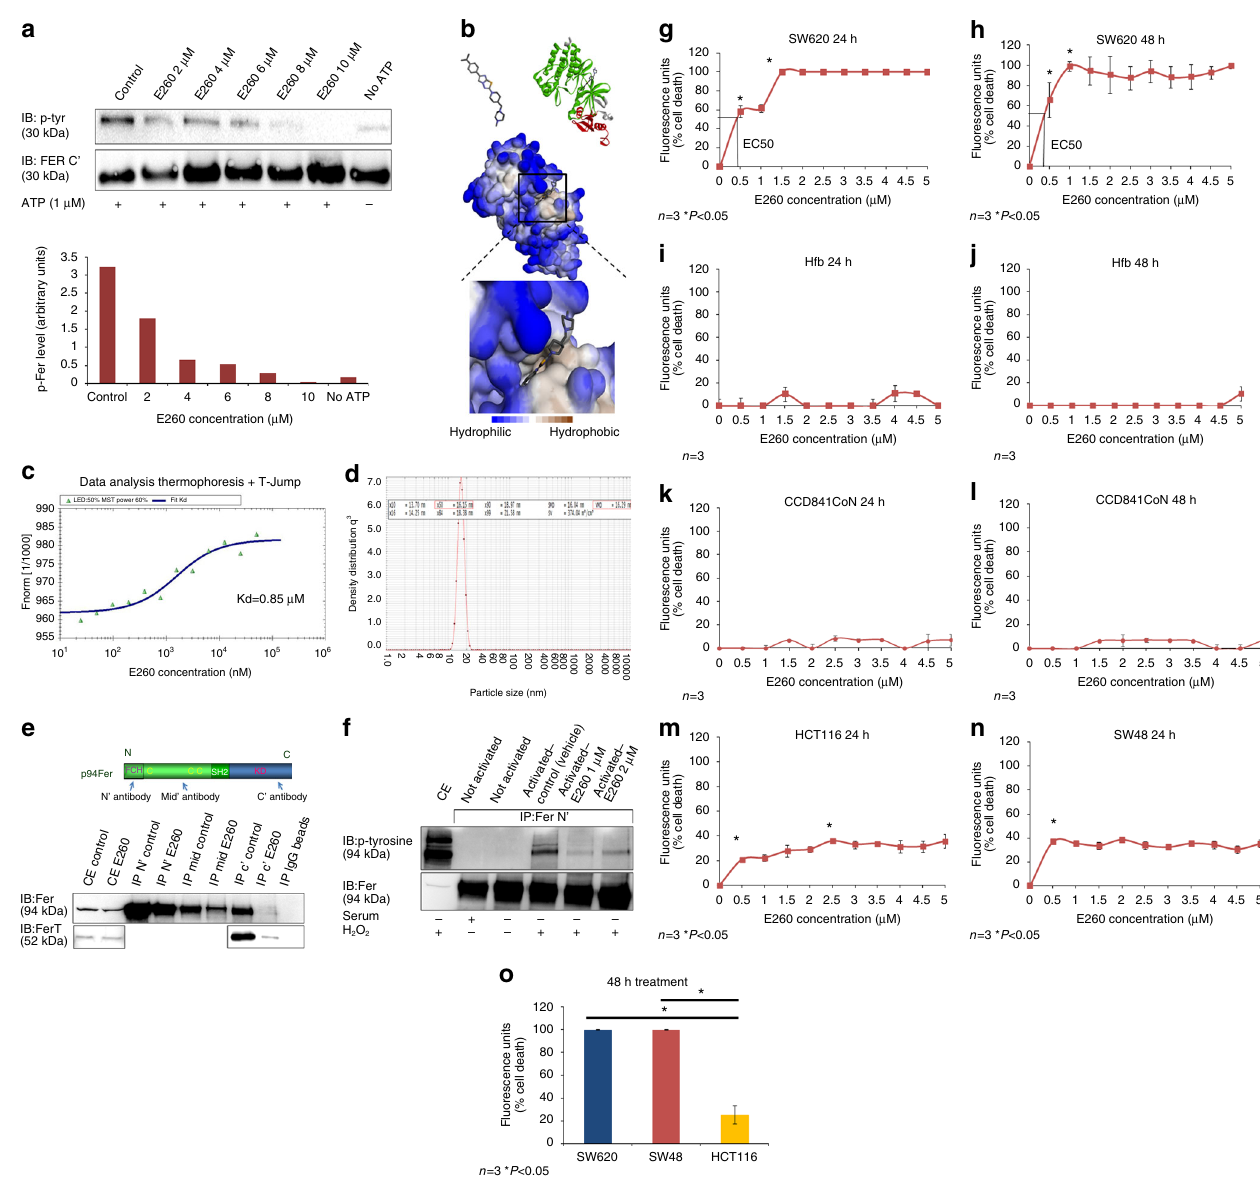
Fig. 2 E260 binds the Fer/FerT KD and inhibits its activity. a In vitro auto-phosphorylation of a recombinant Fer/FerT KD incubated with ATP and ascending concentrations of E260 visualized by WB analysis. Phosphorylation levels (p-tyr) normalized to the Fer/FerT KD levels (Fer C ′ ) are depicted by the histograms presented in the lower panel . b Computational model of E260 docking into the Fer/FerT KD. c MST analysis of E260 binding to Fer/FerT KD and the obtained dissociation constant. d Post formulation DLS volume measurement of micelles incorporated with E260. e Upper panel depicts the Fer protein functional domains and the antibody binding sites used for immunoprecipitation. Lower panel presents a WB analysis of the Fer and FerT proteins immunoprecipitated from SW620 cells left untreated or treated with 2 µ M E260 for 16 h ( upper blot and lower blot , respectively). One experiment representative of three is presented. f IP of Fer from cells in which Fer was not activated or activated (serum starved and H 2 O 2 treated) and untreated (vehicle alone) or treated with E260 for 12 h. Fer inhibition in cells was manifested by its reduced tyrosine auto-phosphorylation (marked by an arrow ), which was detected using anti-phosphotyrosine antibodies in a WB analysis. Dose-response curve depicting the death levels of SW620 cells treated with increasing concentrations of E260 for 24 h ( g ) or 48 h ( h ); n = 3, ± SE. Dose-response curve depicting the death levels of normal human fi broblast (Hfb) cells treated with increasing concentrations of E260 for 24 h ( i ) or 48 h ( j ); n = 3, ± SE. Dose-response curve depicting the death levels of CCD841CoN normal epithelial cells treated with increasing concentrations of E260 for 24 h ( k ) or 48 h ( l ); n = 3, ± SE. Dose-response curve depicting the death levels of HCT116 cells ( m ) and SW48 ( n ) cells treated with increasing concentrations of E260 for 24 h; n = 3, ± SE. o Histograms depicting the death level of SW620 ( blue ), SW48 ( red ), and HCT116 ( yellow ) cells treated with 2 µ M E260 for 48 h; n = 3, ±